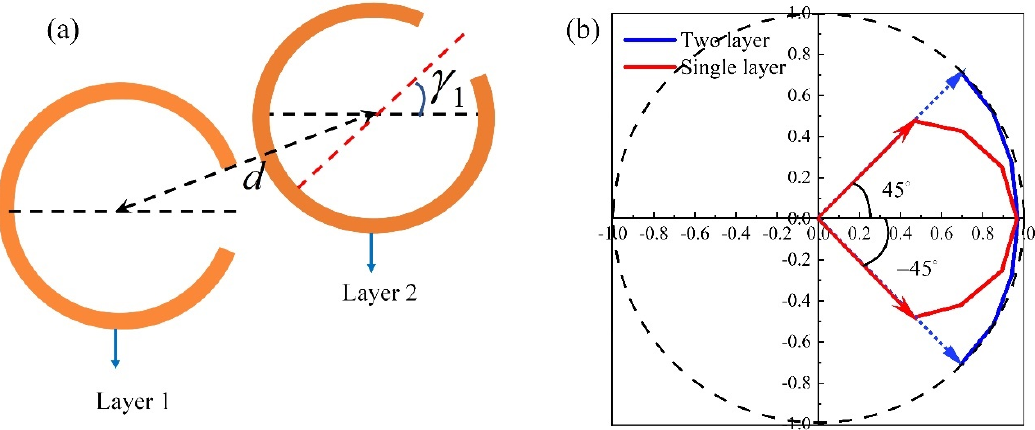
Figure 3. ( a ) Two-layer circular-shape SRR. ( b ) Electric field vector variation of the scattered light at 0.84 THz with rotation angle γ 1 varying from − 45° to +45°, where the red and blue line represent the single-layer and two-layer metasurface, respectively.